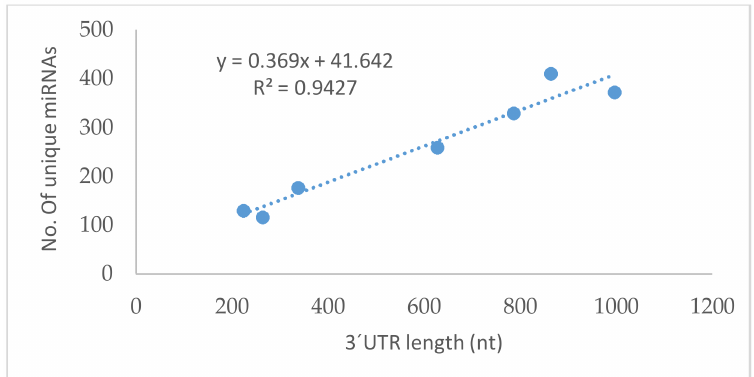
Figure 1. Correlation between 3 (cid:48) UTR length (nt) of selected genes and the number of unique miRNAs predicted by all used algorithms ( GPx8 is not included in the